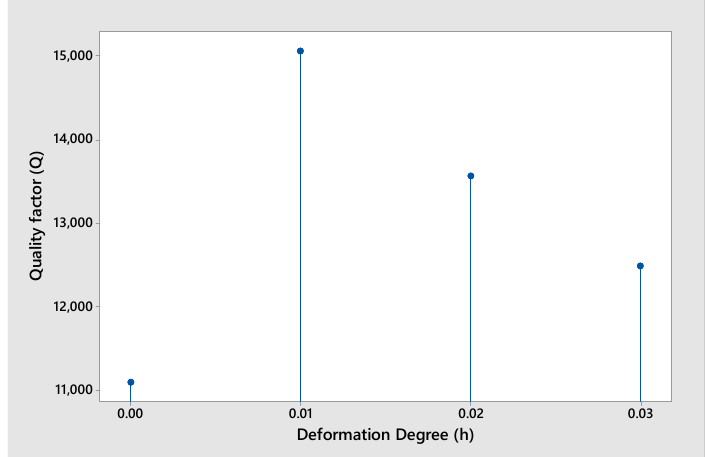
Figure 5. Variation of Q-factor as a function of the deformation degree ( h ) for a photonic structure with 50 alternated layers of fused silica and TiO 2 and with a middle cavity filled with seawater of 50% salinity and at room temperature.